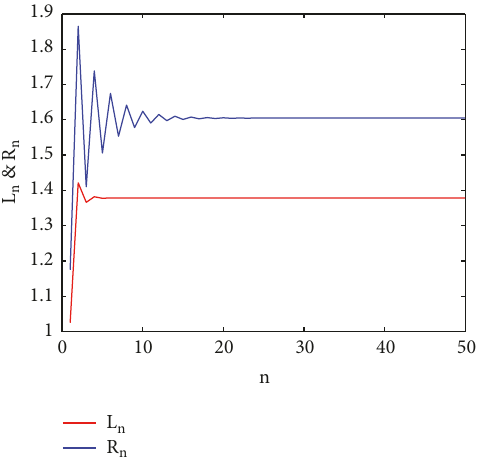
Figure 3: The solution of system (64) at 𝛼 = 0.25.